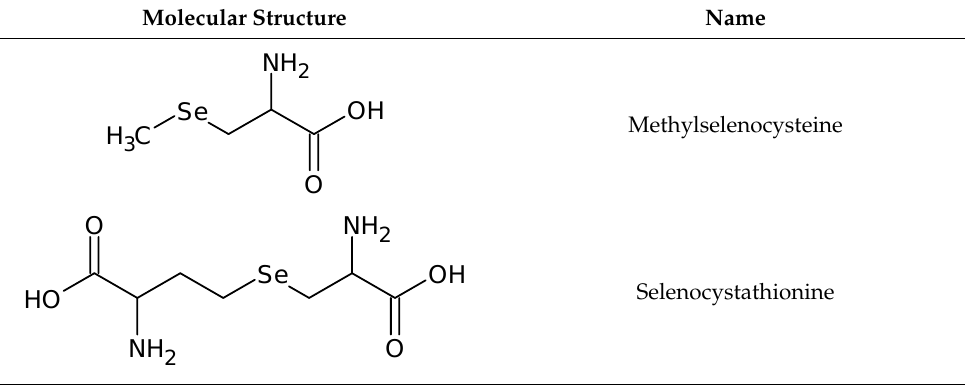
Table 2. Cont. Molecular